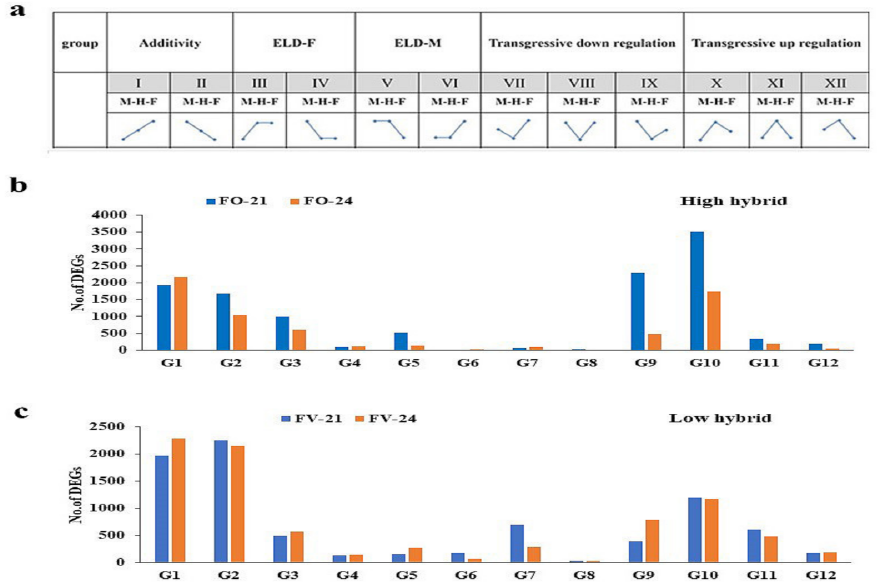
Figure 3. The 12 obtained patterns of gene expression in the root samples of F1 hybrids compared to their parents. ( a ) The pattern of gene expression is divided into 12 groups. M refers to the male parent; H refers to the hybrid; and F refers to the female parent. ( b , c ) The distribution of the total number of DEGs into 12 groups (G1:G12) in the roots of the high (FO) and low (FV) hybrids.